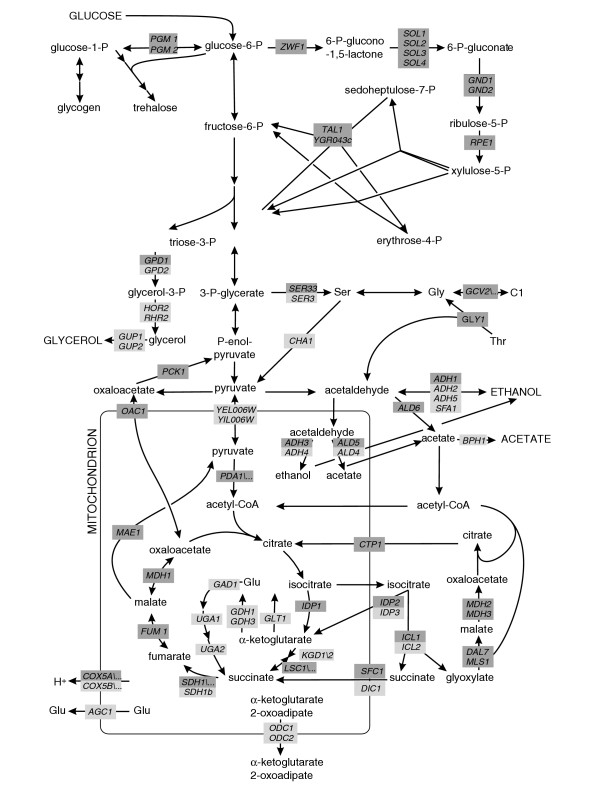
Central carbon metabolism of S. cerevisiae during aerobic growth on glucose. Gene names in boxes are given for reactions that were identified as flexible by flux balance analysis. Dark gray boxes indicate mutants, for which the carbon flux distribution was determined by 13C-tracer experiments. Dots indicate that the gene is part of a protein complex. Arrowheads indicate reaction reversibility. Extracellular substrates and products are capitalized. C1, one-carbon unit from C1 metabolism.